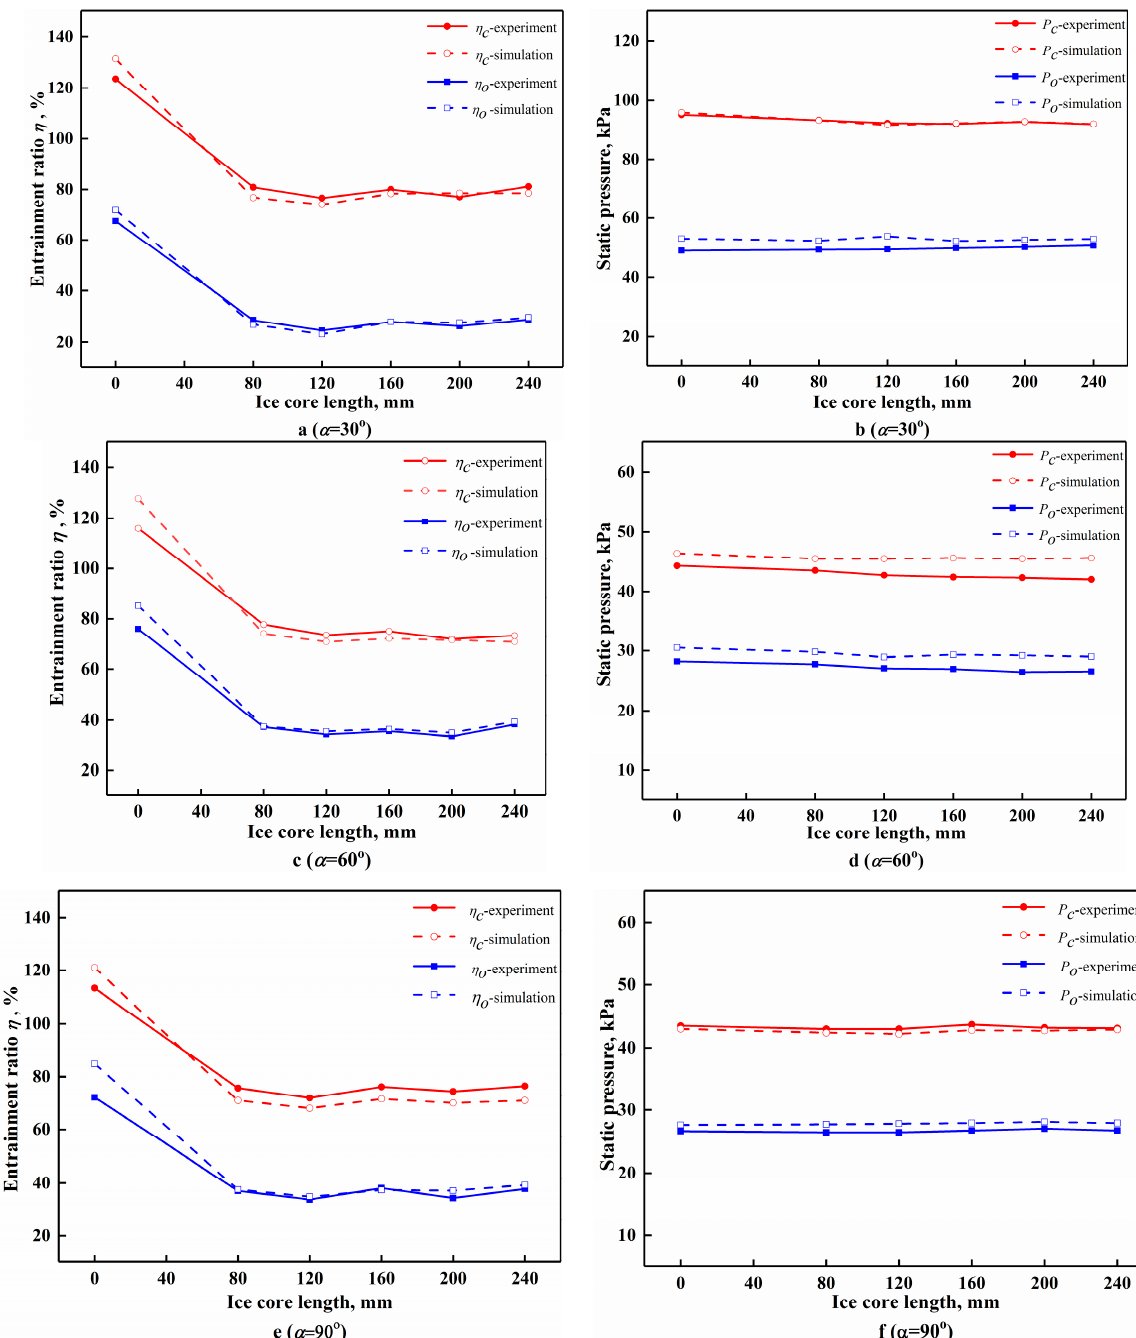
Figure 5. Comparison of simulation and experimental results. ( a ) entrainment ratio of 30°; ( b ) static pressure of 30°; ( c ) entrainment ratio of 60°; ( d ) static pressure of 60° ; ( e ) entrainment ratio of 90°; ( f ) static pressure of 90°.